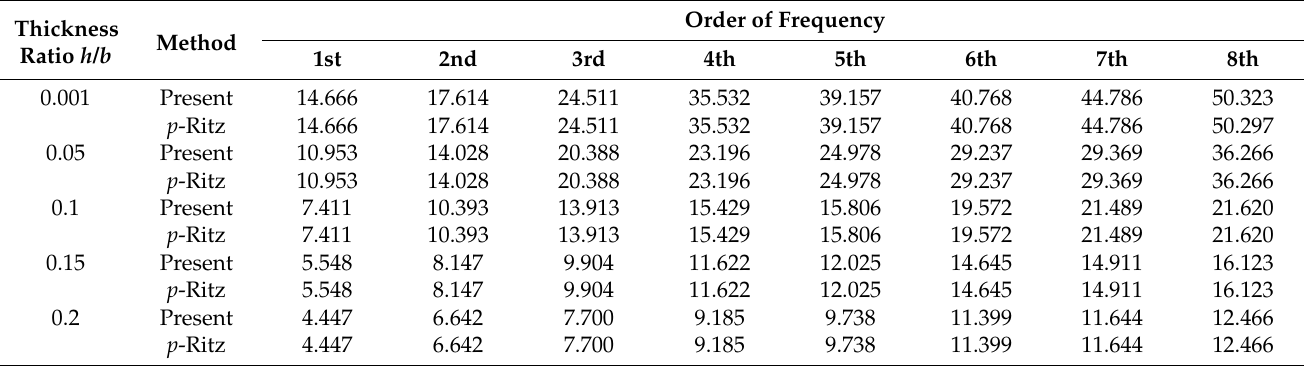
Table 4. The nondimensional frequency Ω for CCCC